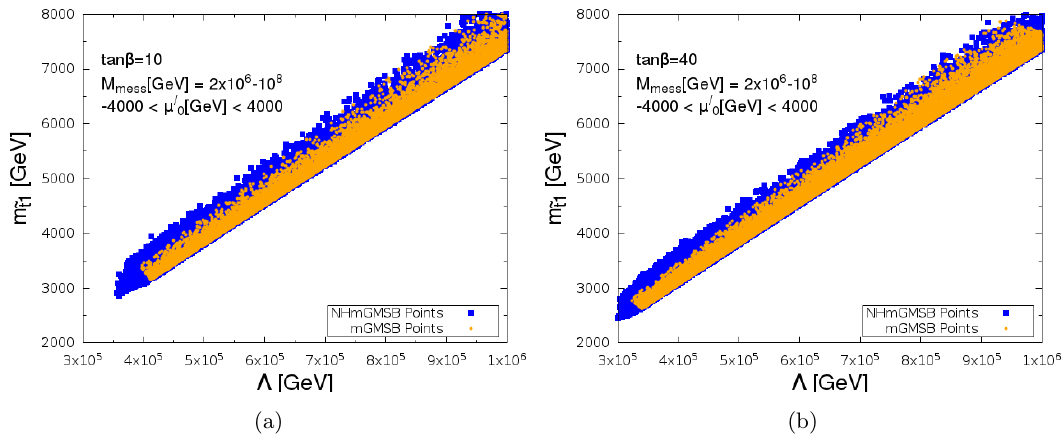
Figure 3 . Scatter plots of the lighter top-squark mass m ~ scanning ranges mentioned in eq. (3.2). The blue and yellow zones refer to the results of NHmGMSB and mGMSB respectively.